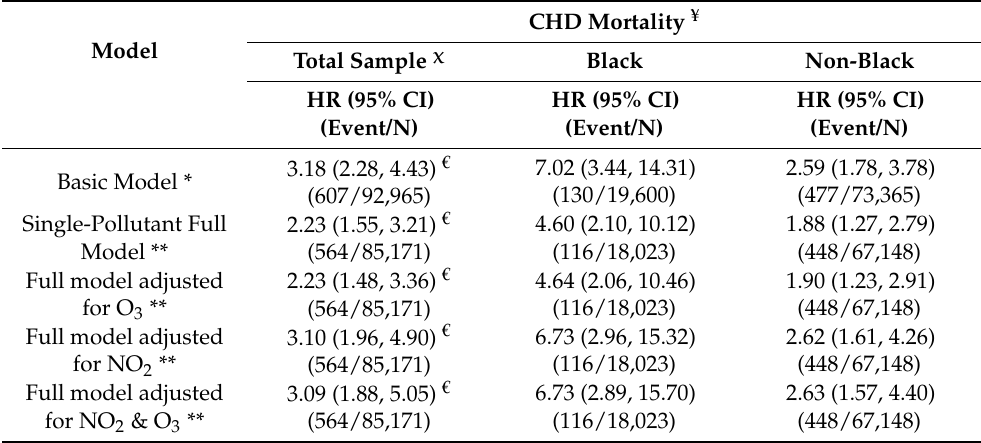
Table 4. Multivariable-Adjusted Hazard Ratios for CHD Fatal Events per 10 µ g/m 3 Increment of PM 2.5 : Single-Pollutant and Two-Pollutant Models by